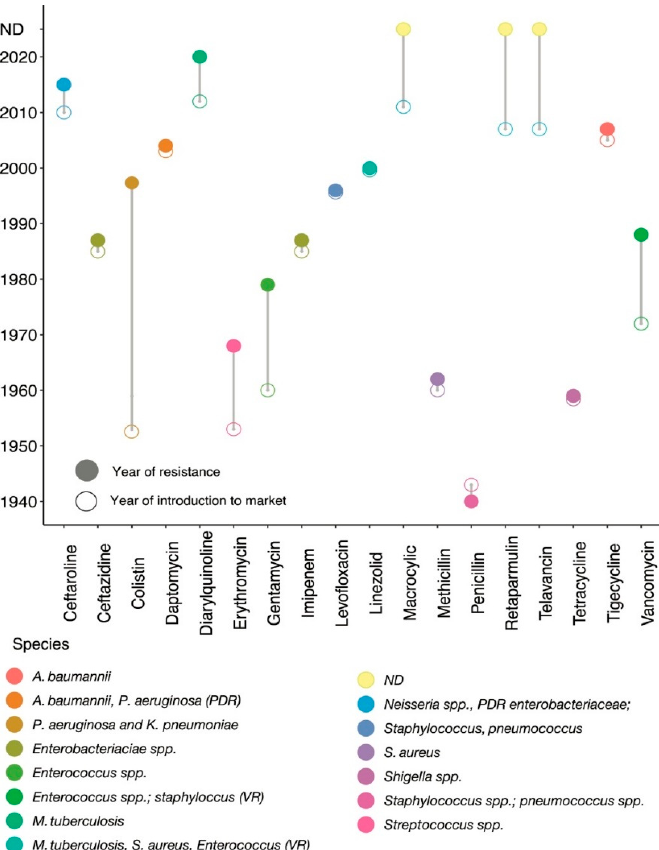
Figure 1. Historical panorama of antibiotic launch and resistance detection. The x-axis indicates different types of antibiotics and the corresponding y-axis shows the year of introduction into clinical practices. Resistance histories to different antibiotics are shown by different circles. Connecting line between empty and filled coloured circles shows the year of introduction of a specific antibiotic into clinical practice and the year of resistance observed for that antibiotic; each coloured circle further represents different bacterial species. For example, colistin was first introduced into clinical practice in 1952 [13], but resistance to colistin was first reported in clinical P. aeruginosa and K. pneumoniae (shown by a specific coloured circle) in 1998 [14]. Penicillin resistant laboratory E. coli was reported in 1950 [15] before its introduction into clinical practice in 1941, but the first penicillin resistance clinical S. aureus was reported in 1942 [16,17]. PDR: pan-drug resistant; VR: vancomycin resistant; spp: species; ND: resistance mechanism not